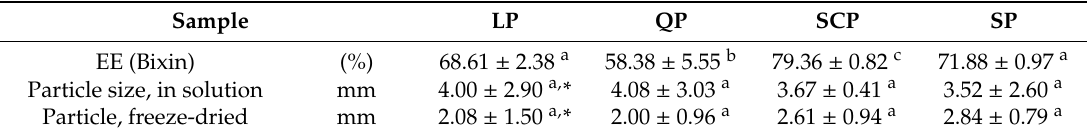
Figure 1. Model photograph of encapsulated annatto extract in solution used to determine particle size. ( a ) Encapsulated extract with lentil proteins, ( b ) encapsulated extract with quinoa proteins, ( c ) encapsulated extract with sodium caseinate, and ( d ) encapsulated extract with soy proteins. Table 1. Comparison of the encapsulation e ffi ciency and particle size of encapsulated annatto